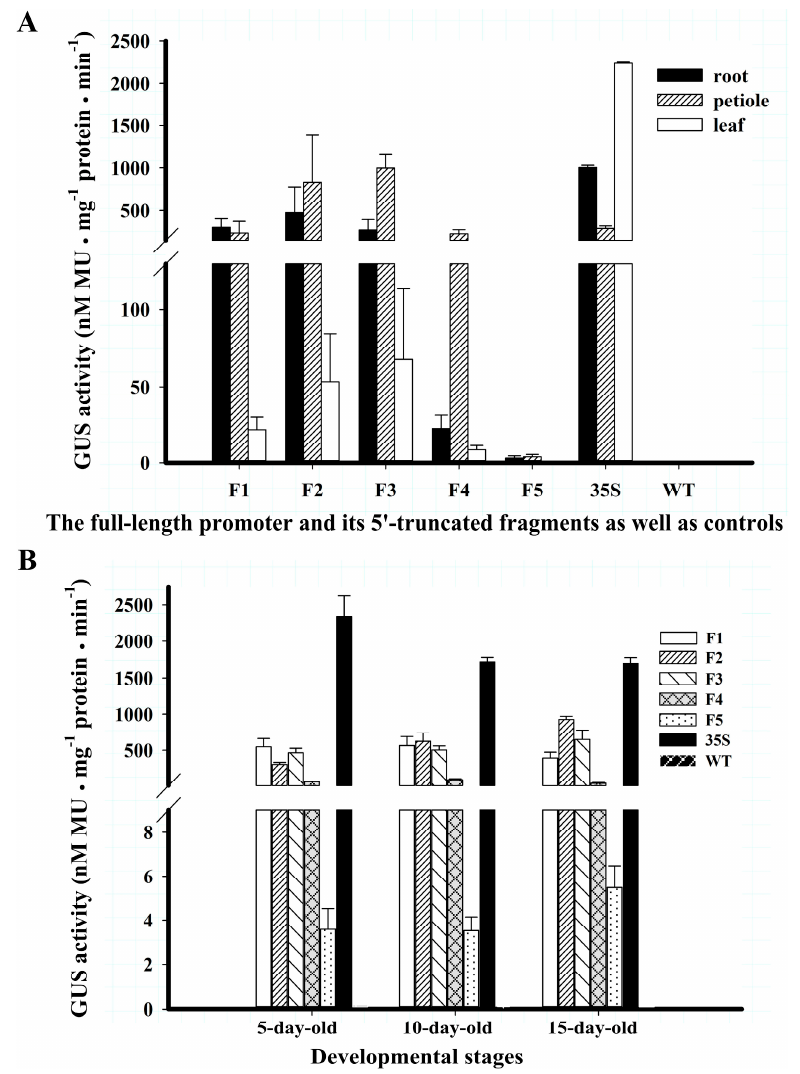
Figure 3. The GUS activities of T 3 Arabidopsis. Data are shown as mean values of three independent lines of each construct ± SD. ( A ) The GUS activity measured in root, petiole and leaf of 15-day-old different construct transgenic seedlings; ( B ) GUS activity driven by serial 5 ′ -truncated BvcPPOPs and CaMV 35S as well as WT control in different developmental stages. GUS activity of single line of each construct was present in Figure S3.